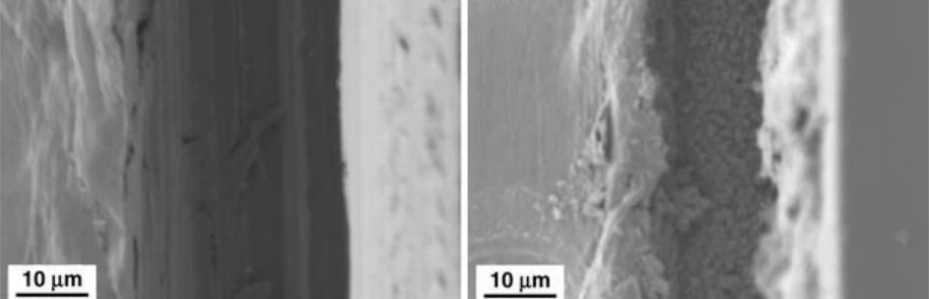
Figure 17. The scratched part of the coating with 5 wt% of SAP AQALIC CS-7S before and after 6 h corrosion test